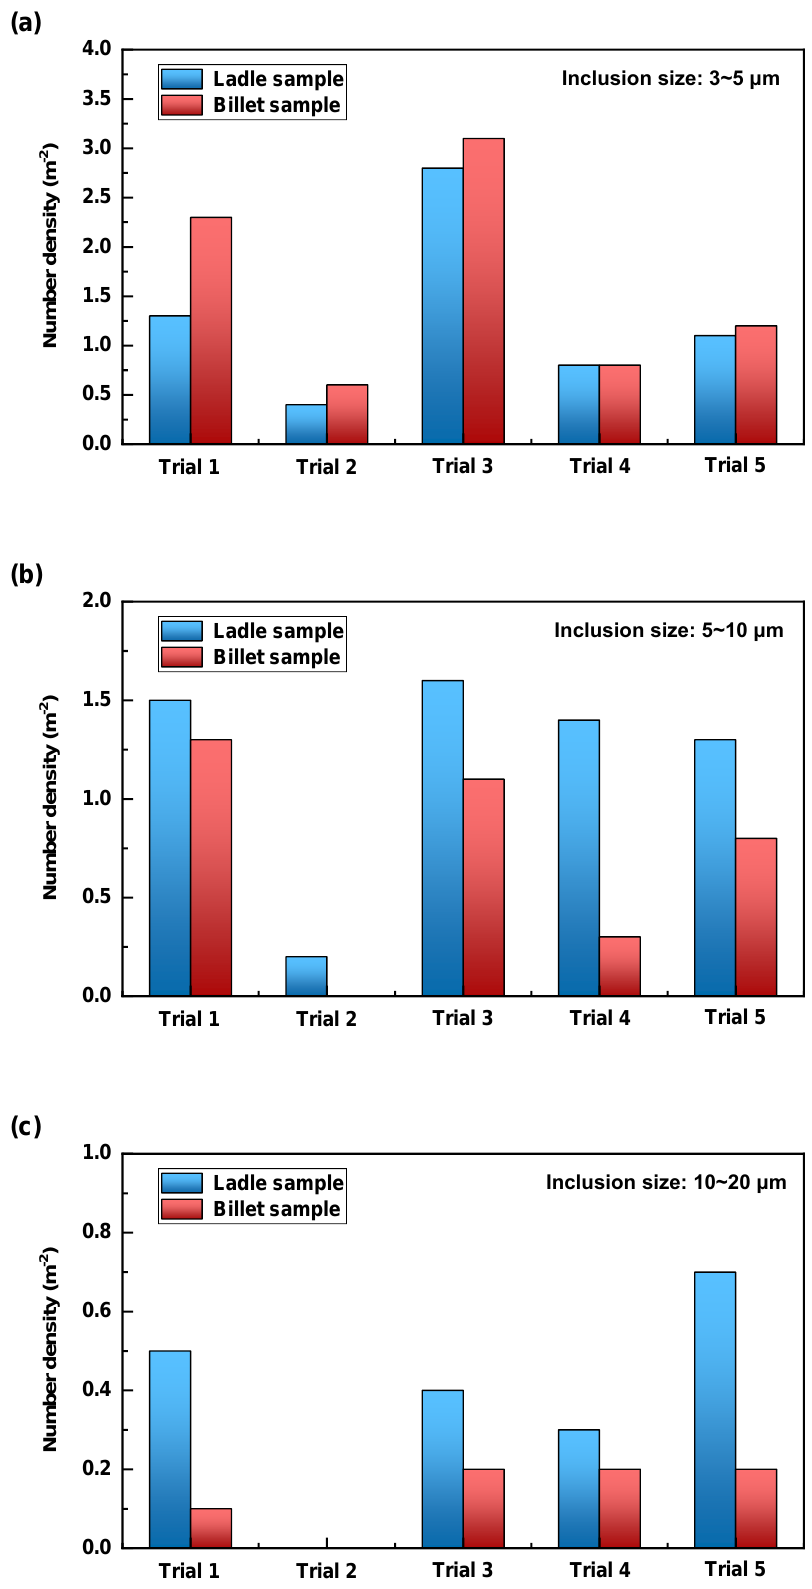
Figure 16. Number density of inclusions of different sizes in steel samples taken from ladle and casting billet for the five industrial trials: ( a ) 3 – 5 μm; ( b ) 5 – 10 μm; ( c ) 10 – 20 μm.